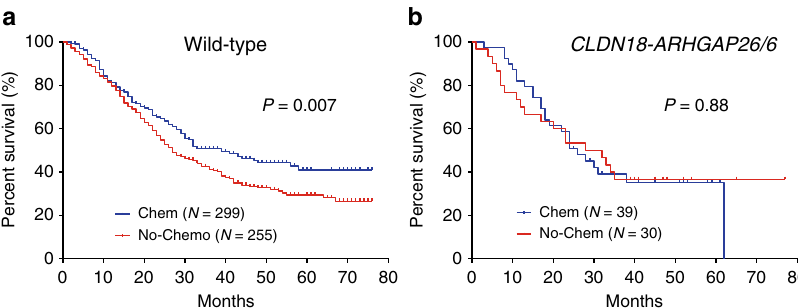
Fig. 5 Impact of CLDN18 - ARHGAP fusion on chemotherapy treatment outcomes.Survival curves with/without chemotherapy treatment in patients without CLDN18-ARHGAP fusion ( a ) or fusion burden ( b ) at stage III and IV. P value was estimated by using Cox